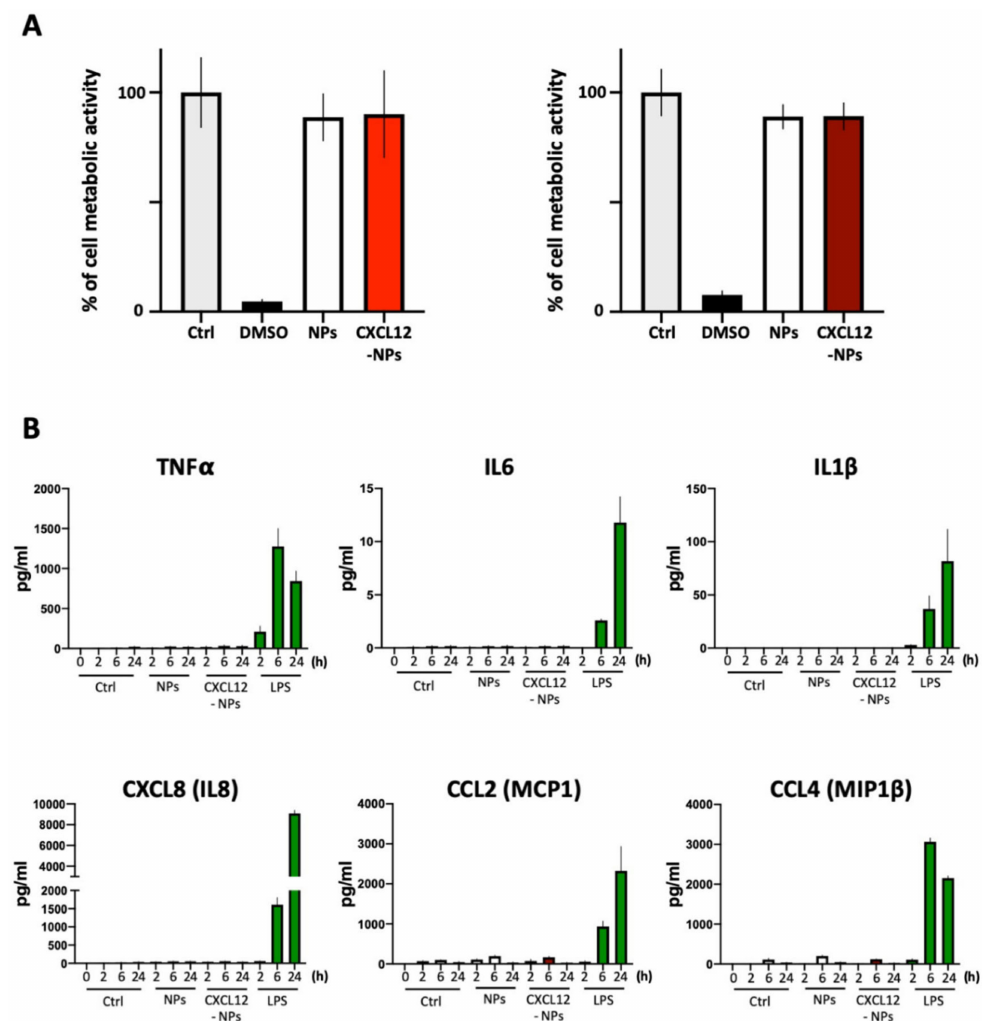
Figure 3. ( A ) Histograms of metabolic activity of THP-1 in two sera supplemented media. Untreated THP-1 cells (Ctrl, light gray bar), THP-1 cells treated with non-functionalized NPs (white bar), CXCL12-NPs(lightredbar)in10%FBS / medium(leftgraph), CXCL12-NPs(darkredbar)5%HS / medium (rightgraph). TenpercentDMSO(black)wasusedaspositivecontrol. Dataarerepresentedinpercentage relative to untreated control. ( B ) Cytokine release. Column graphs show the concentrations of TNF- α , IL-6, IL-1 β , CXCL8, CCL2 and CCL4 released by THP-1 cells in 5% HS / medium, after treatment with non-functionalized NPs (NPs), CXCL12-NPs or 100 ng / mL LPS for 2, 6 and 24 h, measured by Bio-Plex MAGPIX Multiplex Reader. Control (Ctrl) represents untreated cells. Results are expressed in pg / mL. All bars represent at least three independent experiments +/ −